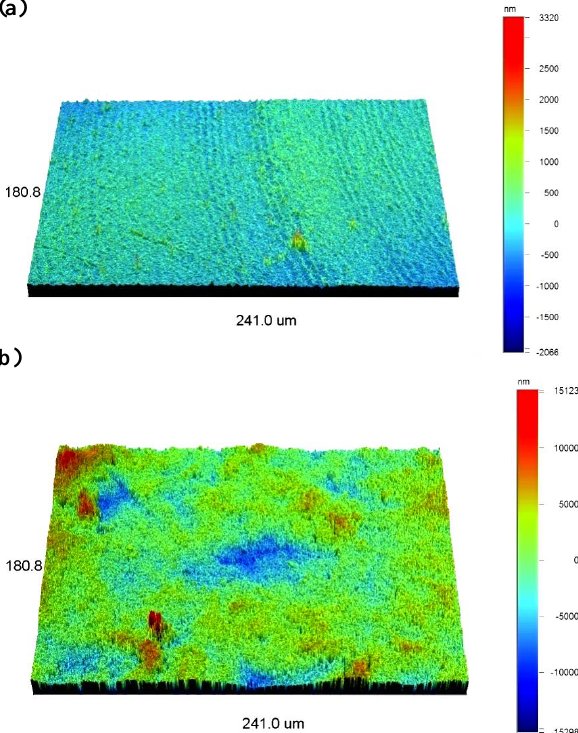
Figure 3. 3D images of surface roughness for PEI composite before ( a ) and after ( b ) sandblasting process.